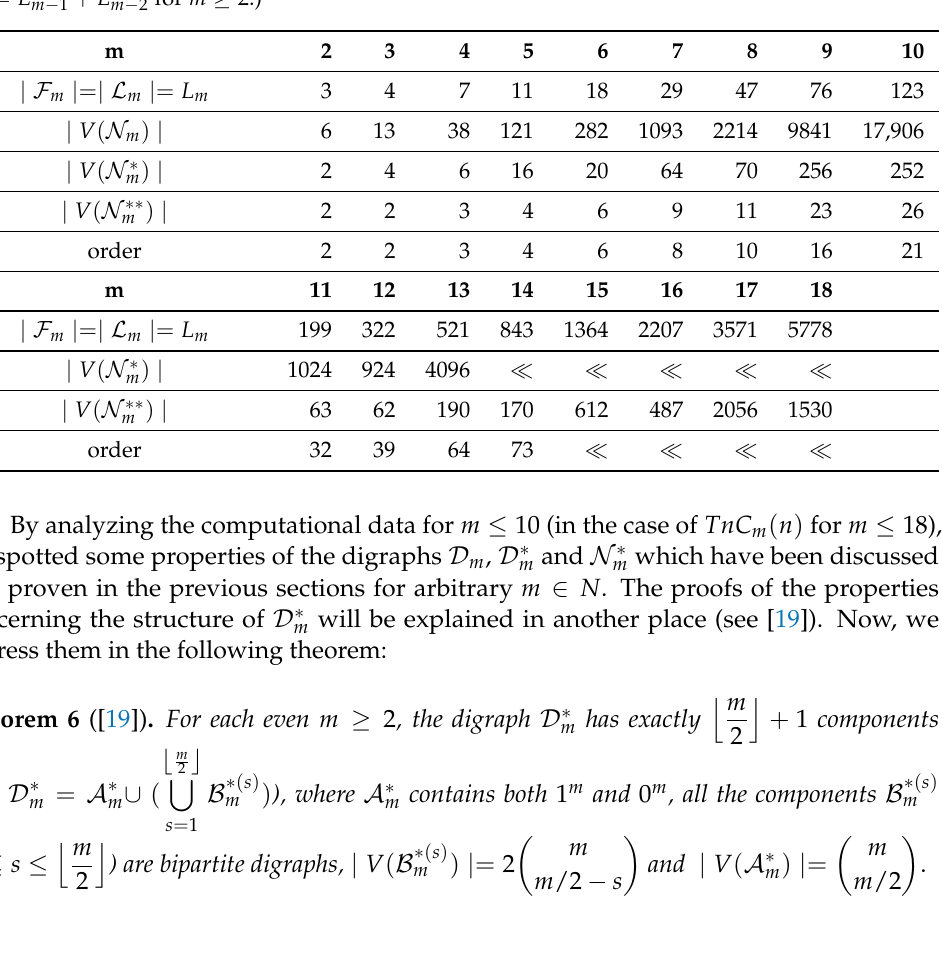
Table 1. The number of vertices for N m , N ∗ m and N ∗∗ m and the order of recurrence relations for the thin cylinder graph C m × P n . ( L m is the m th member of the Lucas sequence L 0 = 2, L 1 = 1 and L m = L m − 1 + L m − 2 for m ≥